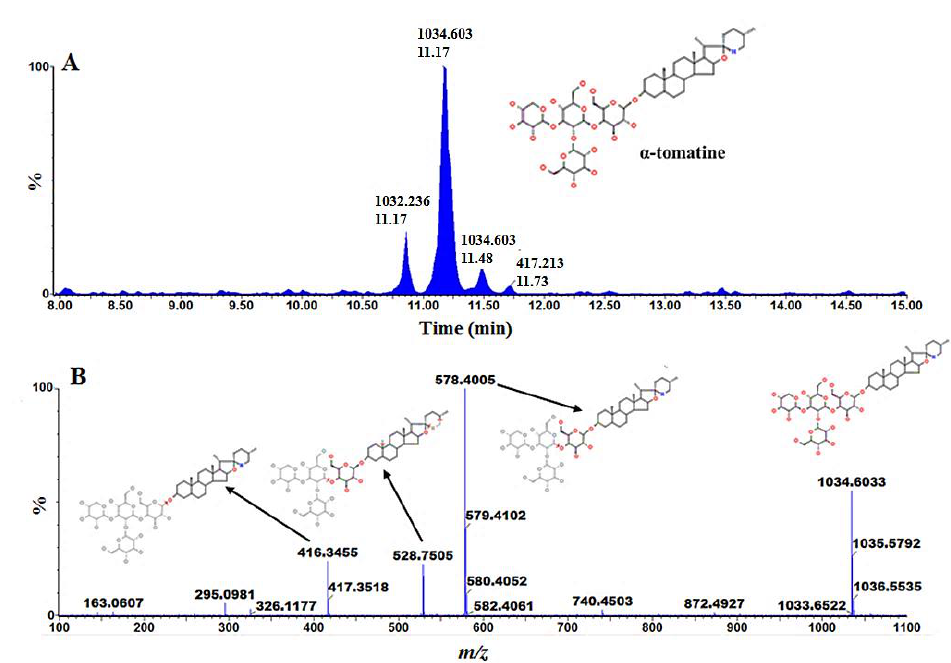
Figure 4. Representative UHPLC-MS / MS single ion chromatogram (XIC) and spectrum of α -tomatine. ( A ) single ion chromatograms (XIC) of UHPLC-MS / MS showing the retention time of α -tomatine. ( B ) MS spectra showing fragmentation patterns of α -tomatine. Annotation of significant ions from the treated tomato plants was performed with the aid of UHPLC-qTOF-MS / MS, based on the “in-source collision-induced dissociation” (ISCID) method as previously reported [31,37]. Single ion chromatograms were extracted and the spectral fragments compared among the di ff erent collision energies and with available spectral information. The mass spectrum of the extracted ion peak was used to deduce the putative empirical formula of the compound. Table 1. Summary of annotated metabolites that contributed to the discriminating variability in the altered/primed metabolomes as described by chemometric models. These discriminating metabolites were identified based on OPLS-DA S-plots, with a rigorous statistical validation. The reported metabolites had VIP scores ˃ 1.0 and were annotated to MSI level 2.